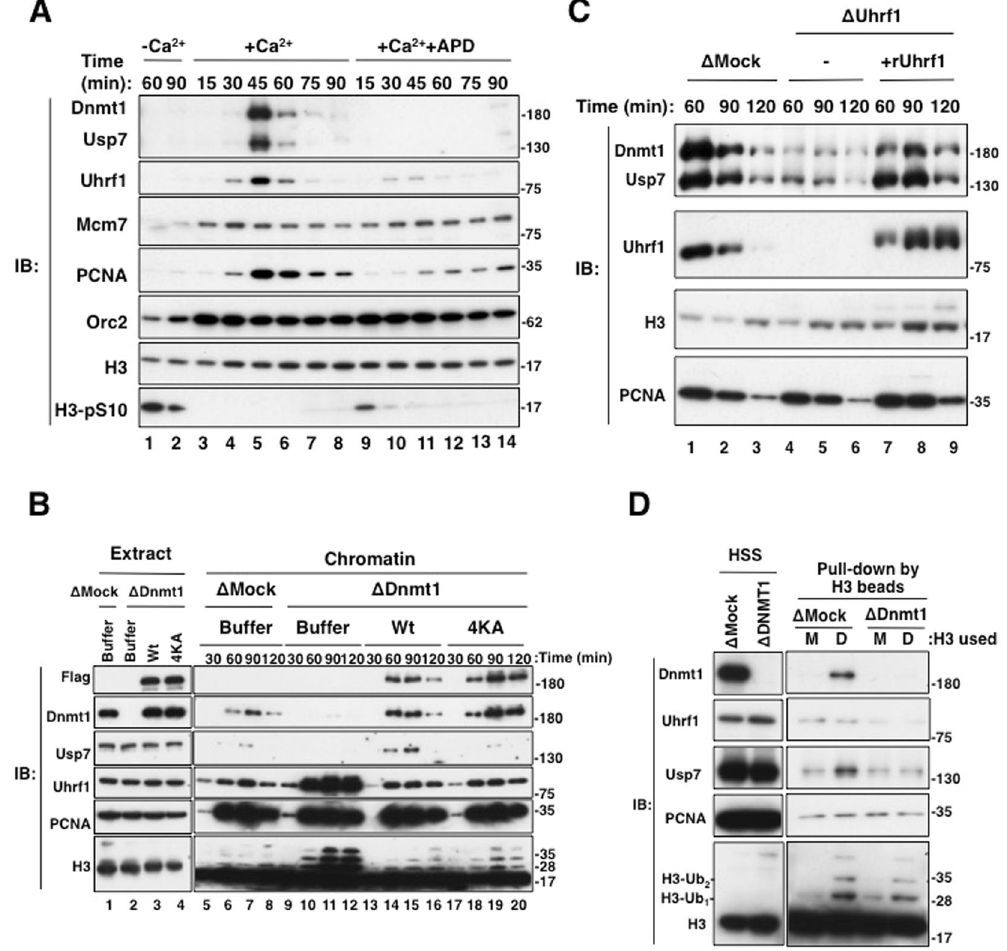
Figure 3. Usp7 binds to replicating chromatin in a Dnmt1-dependent manner. ( A ) CSF extracts (M-phase) were released into interphase by addition of CaCl 2 . Sperm nuclei were added to either CSF or interphase extracts. Aphidicolin (APD, 150 μ M) was added to extracts 10 min before sperm addition. At the indicated times after incubation, chromatin fractions were isolated and subjected to immunoblotting using the antibodies indicated. ( B ) Sperm chromatin was added to mock- or xDnmt1-depleted interphase extracts. xDnmt1- depleted extracts were supplemented with either buffer alone (lanes 9–12), purified wild-type xDnmt1-FLAGx3 or its 4KA mutant-FLAGx3 (10 ng/ μ l final concentration, lanes 13–16 or 17–20, respectively). At the indicated time points, chromatin fractions as well as extracts were subjected to immunoblotting using the antibodies indicated. ∆ Denotes immunodepletion of the protein indicated. ( C ) Sperm chromatin was added to mock-depleted or xUhrf1-depleted interphase extracts. xUhrf1-depleted extracts were supplemented with either buffer alone (lanes 7–9) or purified hUhrf1 (30 ng/ μ l final concentration, lanes 10–12). At the indicated time points, chromatin fractions were isolated and subjected to immunoblotting using the antibodies indicated. Note that xUhrf1 antibodies recognized hUhrf1. ∆ Denotes immunodepletion of the protein indicated. ( D ) Either mock- or Dnmt1-depleted HSS were incubated with chromatin fractions from mock- (M) or Dnmt1- ( D ) depleted extracts. The resultant mixtures were immunoprecipitated with anti-histone H3 antibodies and subjected to immunoblotting using the antibodies indicated. ∆ Denotes immunodepletion of the protein indicated. Source data are available online for this